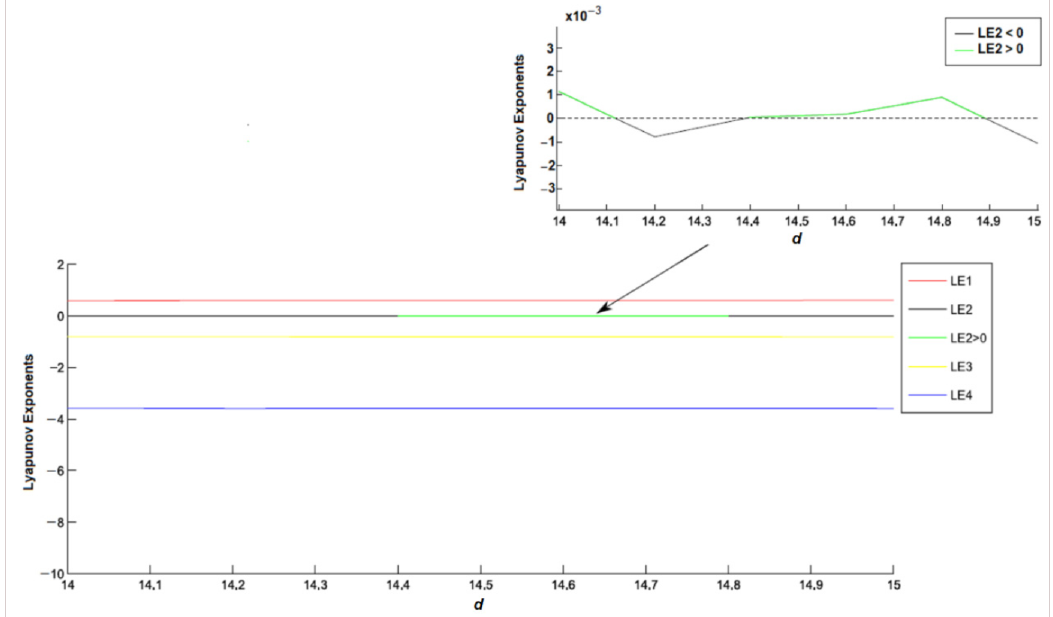
Figure 2. Lyapunov exponents of system (1) with the variation of bifurcation parameter d =